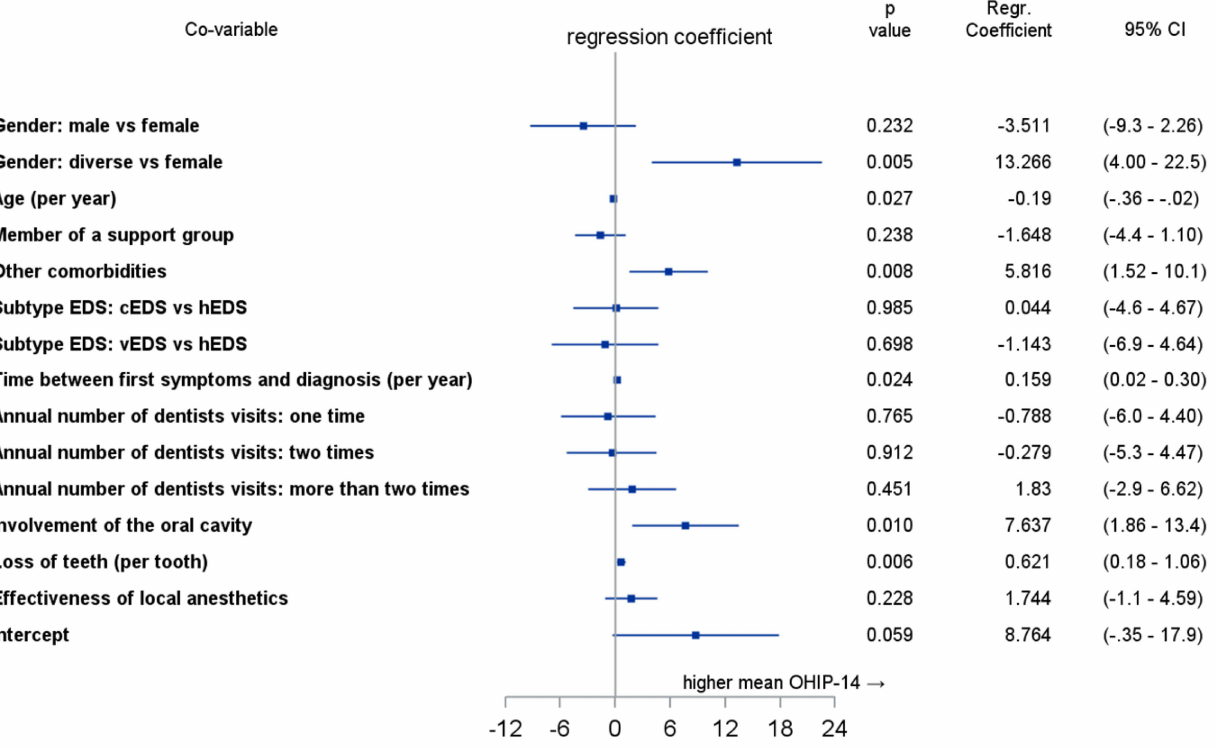
Figure 3. Multivariable linear regression analysis for variables and their impact on Oral Health Impact Profile-14